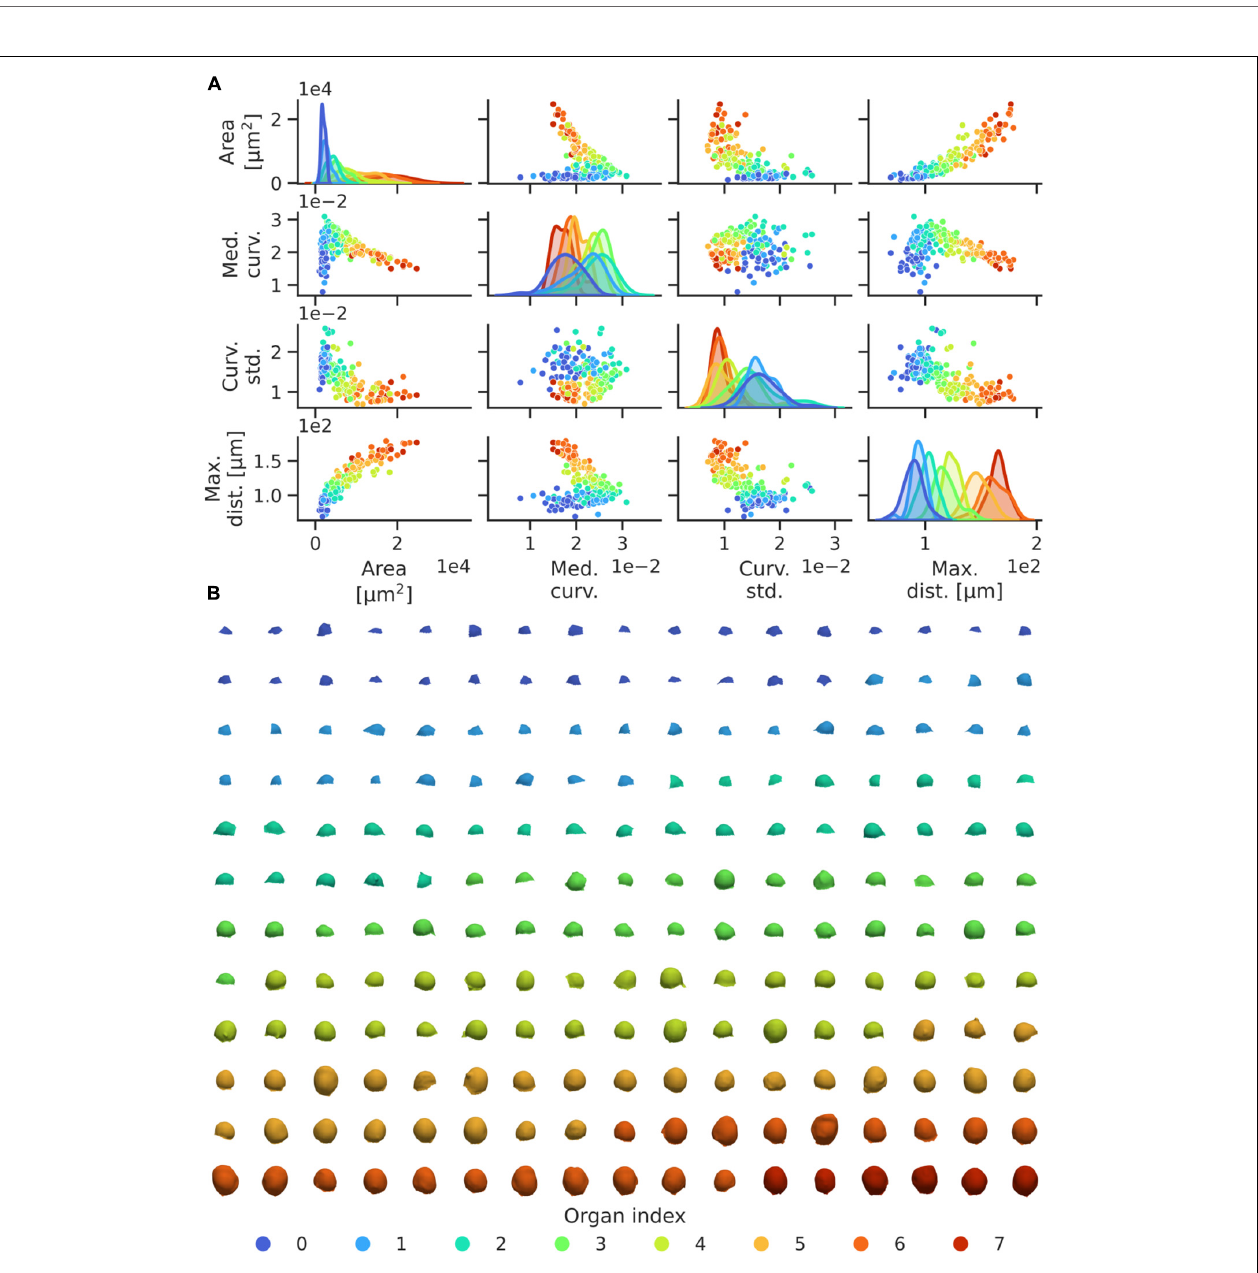
FIGURE 4 | High-throughput geometric feature quantification of WT flower organs enable accurate identification of the development of, and relationship between, morphological features. (A) Pairwise dependencies on mesh surface area, median of the average vertex curvatures, standard deviation of the mean and maximal vertex distance relative to the inflorescence centre of mass for each organ in the dataset. To avoid outlier obfuscation, curvature statistics are truncated to be within the 10 and 90% distribution quantiles, per organ. Organ indices are coloured from the most to least recently initiated primordium. Kernel density estimates (on the diagonal) have areas normalised to 1 for each organ index, and the y-axis represents density. (B) Illustration of the segmented WT flower organs, ordered by left-right, top-bottom in coloured groups corresponding to their phyllotactic index. Generally, organs of a certain index exhibit similar